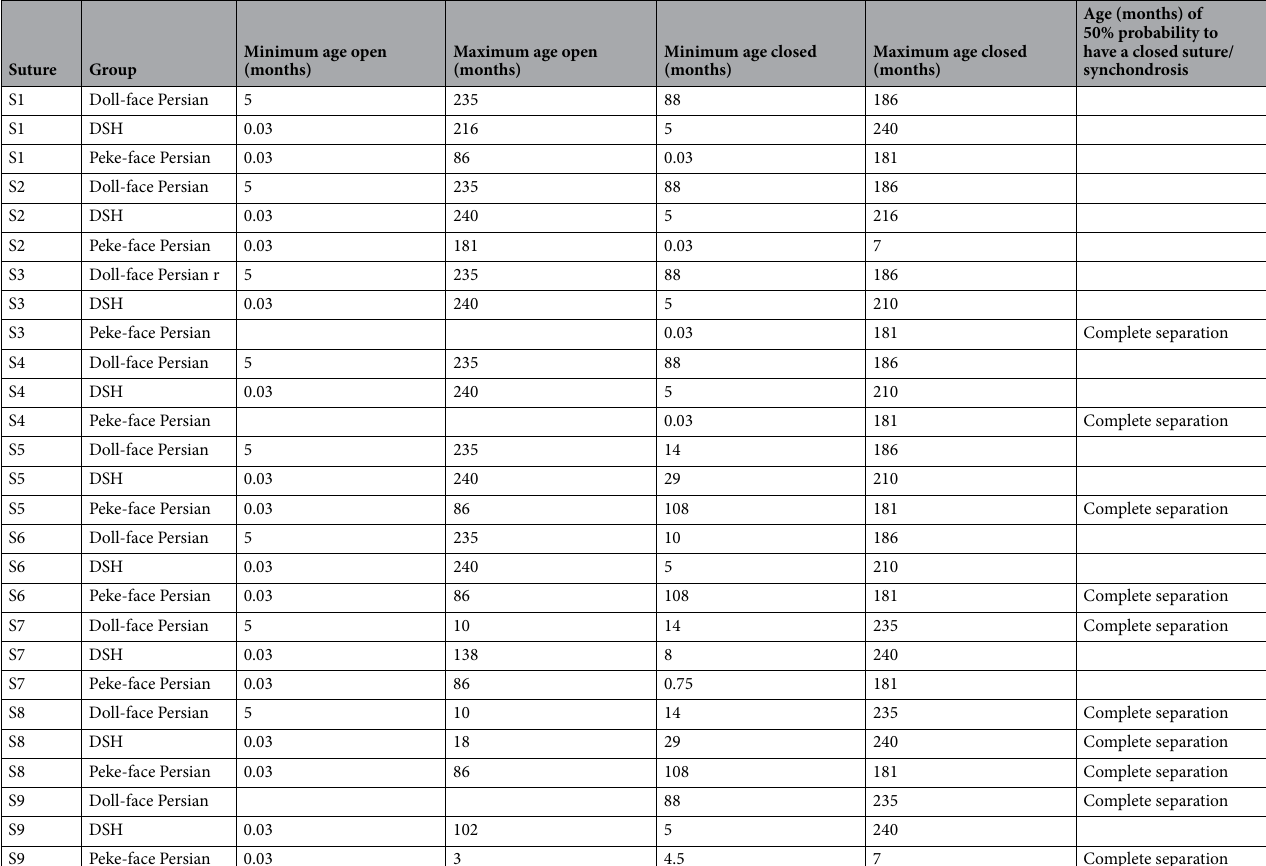
Table 3. Overview of minimum and maximum times in which the sutures and synchondroses were open or closed. S1 sagittal suture, S2 metopic suture, S3 left coronal suture, S4 right coronal suture, S5 left lambdoid suture, S6 right lambdoid suture, S7 intersphenoid synchondrosis, S8 spheno-occipital synchondrosis, S9 spheno-ethmoid synchondrosis.